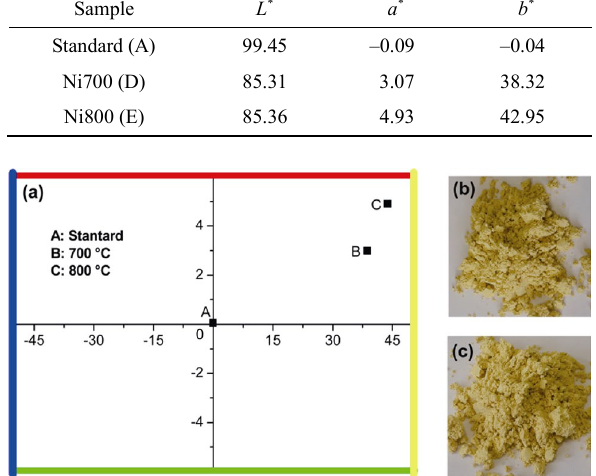
Fig. 4 (a) CIELab graphics of the NiWO 4 samples calcined at 700 and 800 ℃ /2 h. Pictures of samples calcined at (b) 700 and (c) 800 ℃ /2